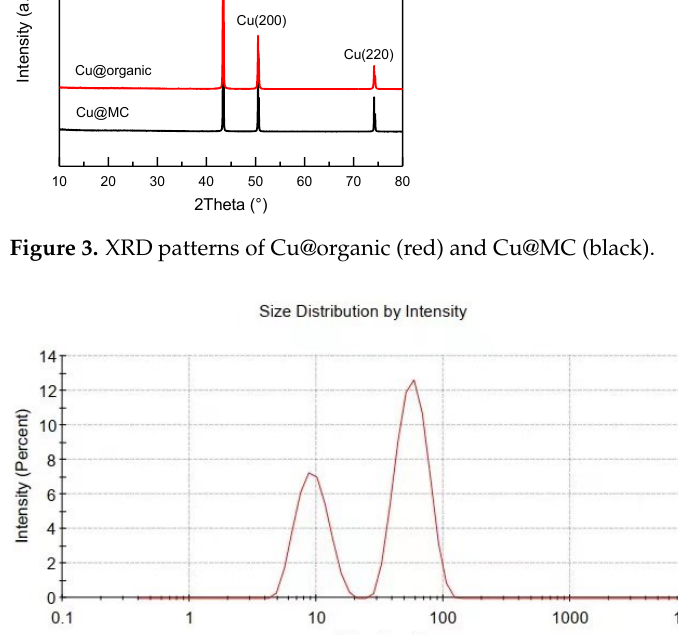
Figure 4. Particle size and distribution of Cu@organic characterized by dynamic light scattering measurement.